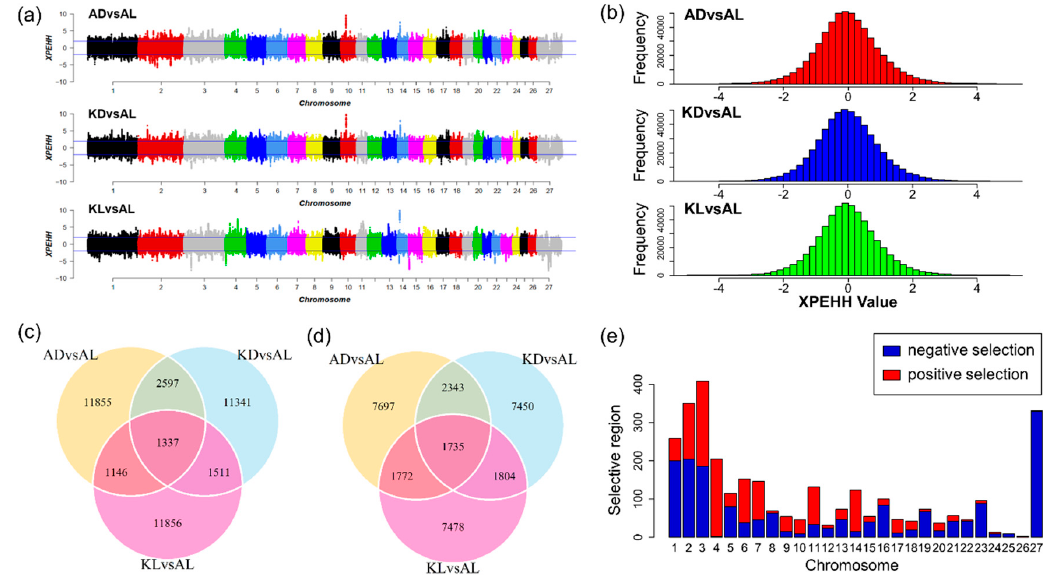
Figure 3. The selection signatures detected by Cross Population Extend Haplotype Homozygosity Test (XPEHH) test. ( a ) Manhattan plots reflect the genome-wide distribution of selection signatures detected by the XPEHH test in each population pair. The multiparous sheep breeds (AD, KD, and KL) are defined as observed population, respectively, and the AL sheep is the reference population. ( b ) The histogram indicates the distribution of XPEHH scores of each population pair. ( c ) The counts of the positive selection signatures in each population pair and the overlap region represent the counts of common core SNPs among three pairs. ( d ) The counts of the negative selection signatures in each population pair and the overlap region represent the counts of common core SNPs among three pairs. ( e ) The distribution of common core SNPs on chromosomes. The bars represent positive selection signatures (red) and negative selection signatures (blue).